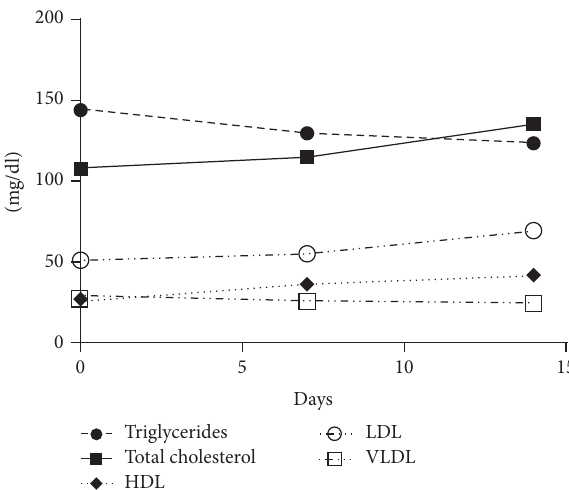
Figure 1:Lipid profileof children with vivax malaria ( ◼ )and control group ( ◻ ).